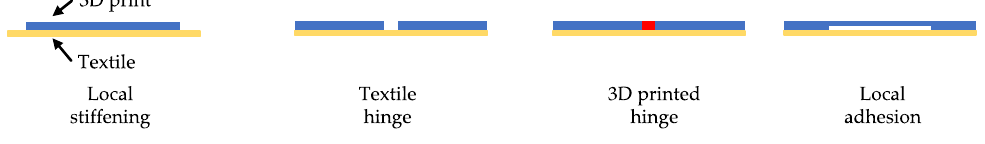
Figure 6. Design primitives for developing 4D textiles.